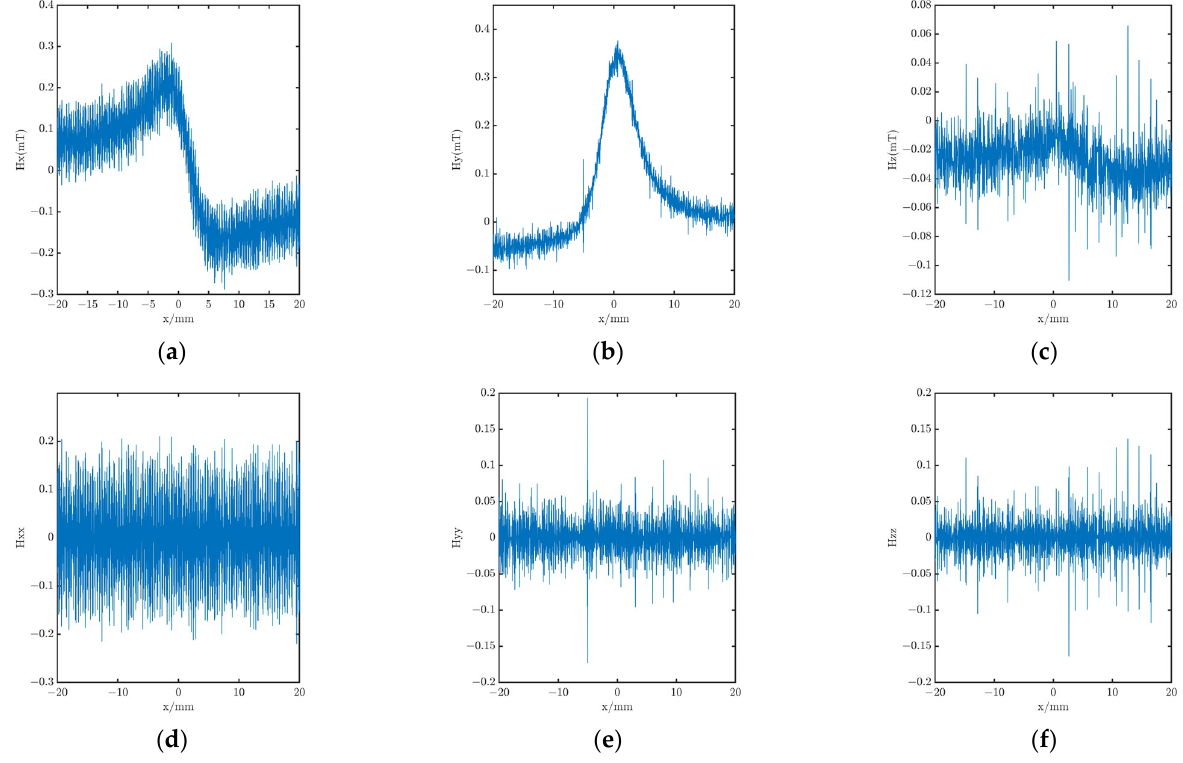
Figure 2. Metal magnetic memory testing signal and magnetic gradient signal. ( a ) Normal component signal. ( b ) Tangential component signal. ( c ) Horizontal component signal. ( d ) Gradient value of the normal component signal. ( e ) Gradient value of the tangential component testing signal. ( f ) Gradient value of the horizontal component testing signal.